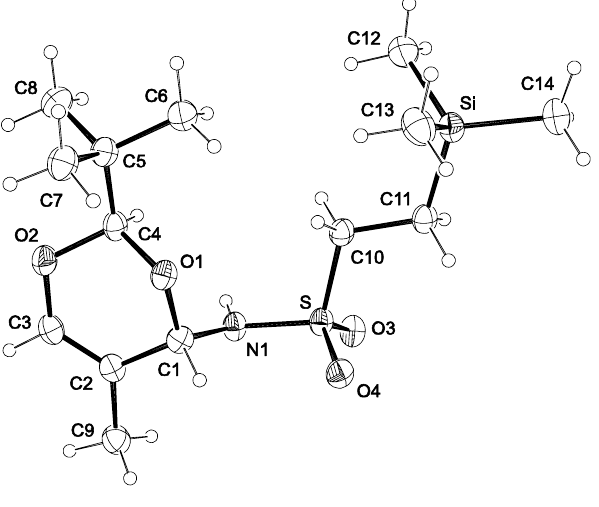
a single diastereomer according NMR data. The crystal structure was determined to establish the relative configuration. The bond lengths and angles are in normal ranges. A weak NH···O bond